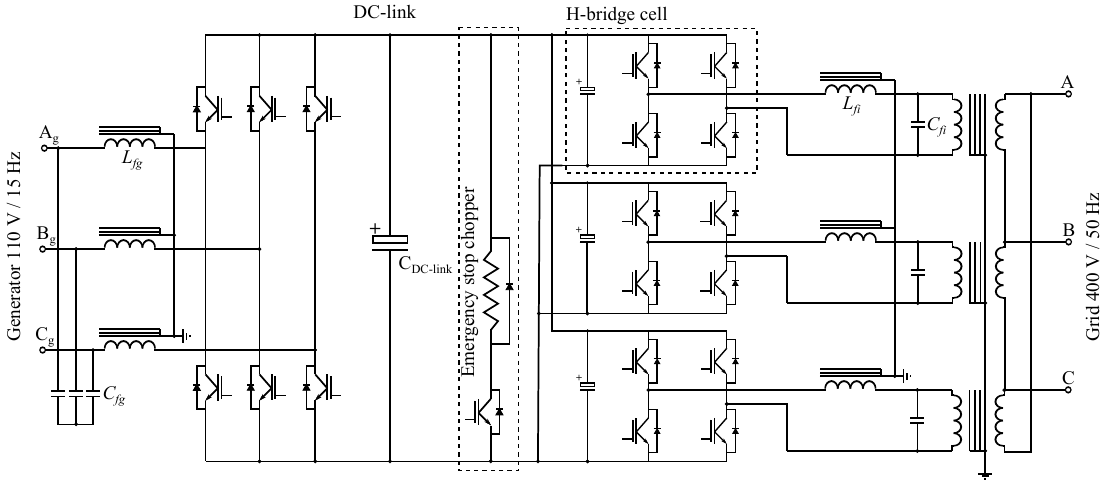
Figure 3. The electrical system for the grid connection of the marine current energy converter. An insulated-gate bipolar transistor (IGBT) based two-level converter generator-side with an IGBT based cascaded three-level converter grid-side with LC filters on both